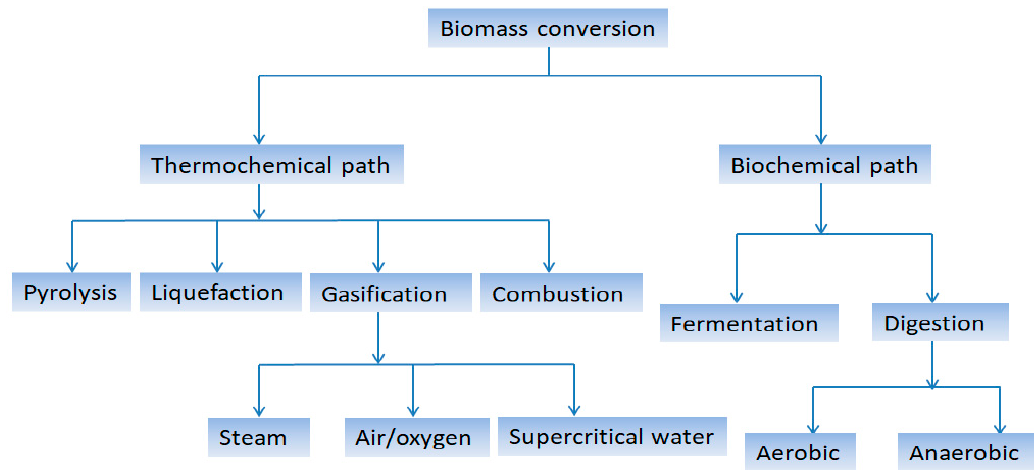
Figure 9. Overview of common biomass conversion processes. Adapted with permission from [65].